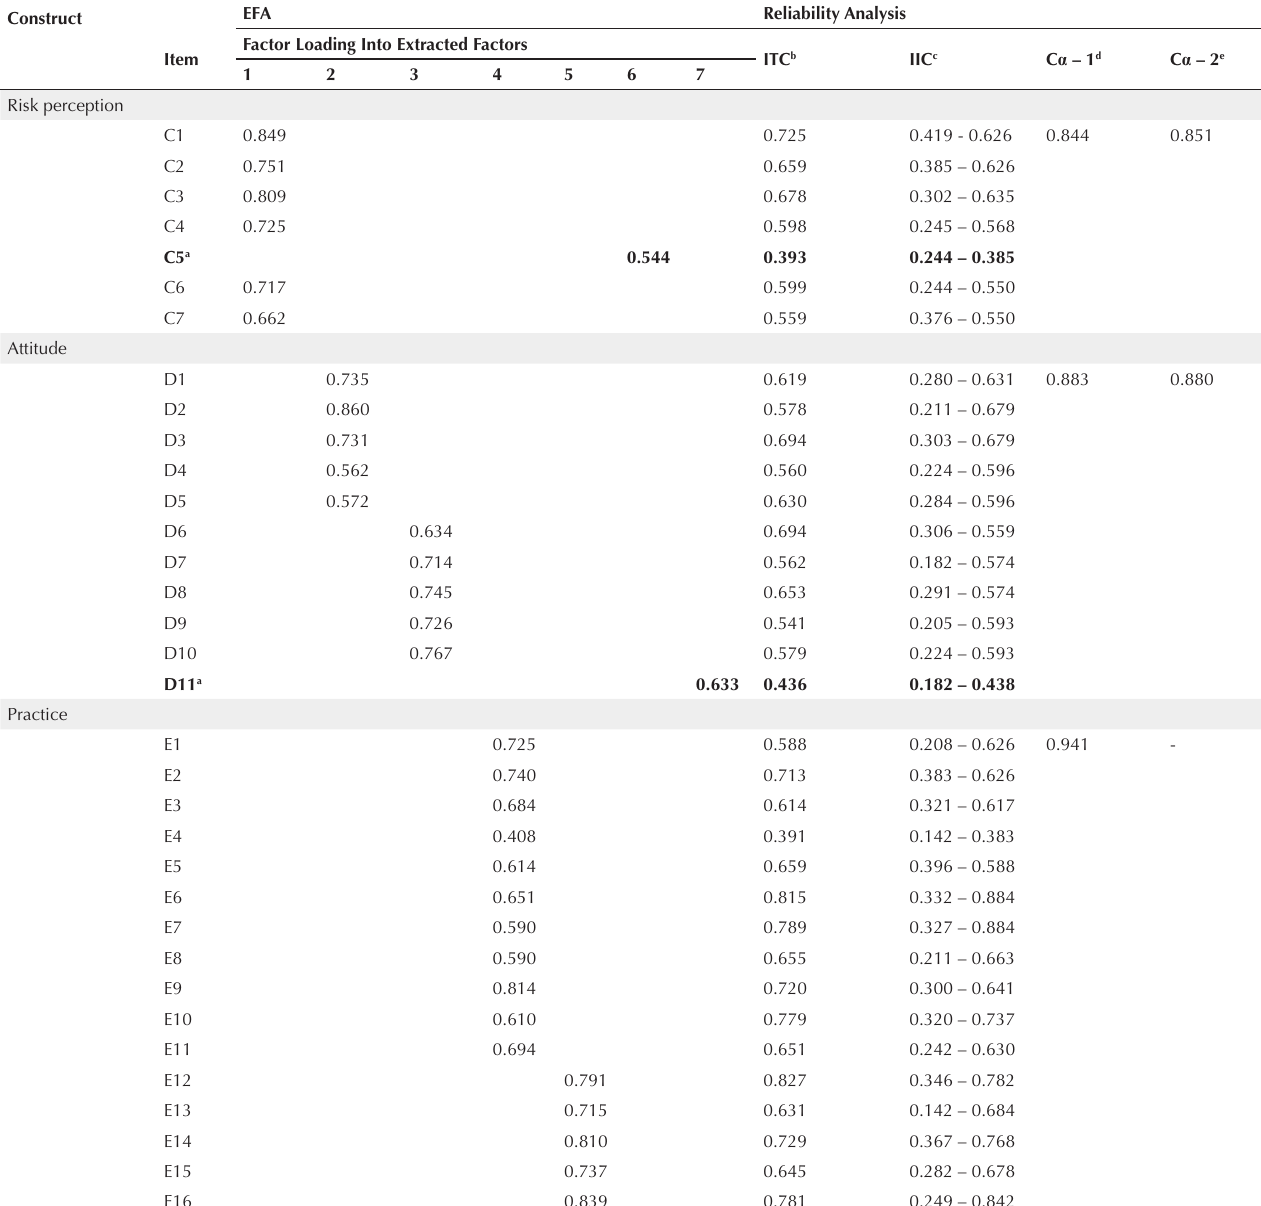
Table 2. Results of Exploratory Factor Analysis and Reliability Analysis of All 34 Items With Respective Factor Loadings, ITC, IIC, and Construct-Specific Cronbach α Before and After Item